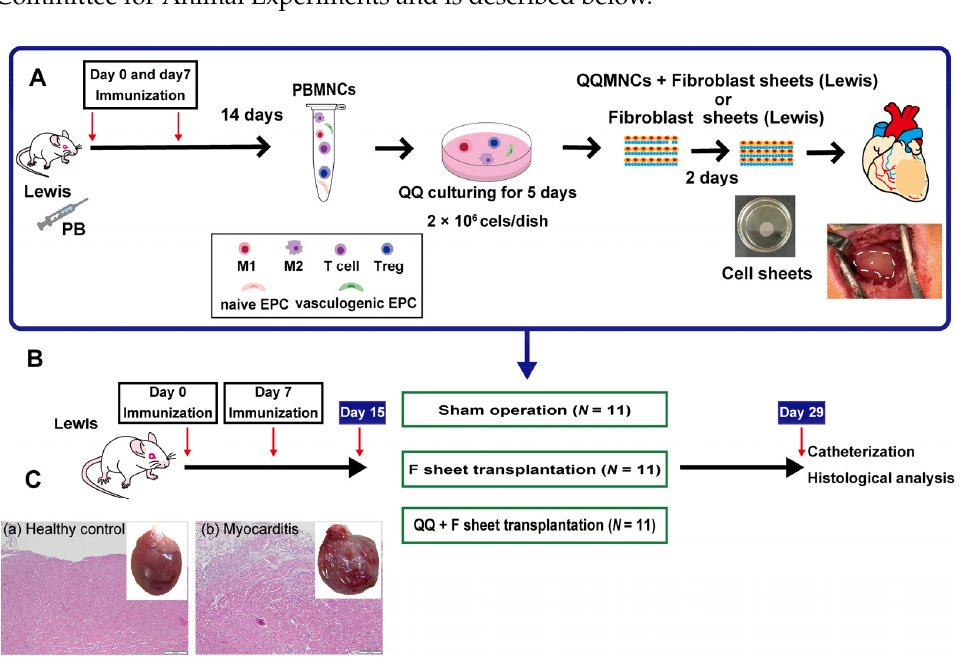
Figure 1. Experimental protocol. ( A ) Schematic flowchart of the in vitro protocol; Differentiation and purification of QQMNCs from rat peripheral blood and three harvested QQMNCs and fibroblast sheets (F-sheets). ( B ) Schematic flowchart of the in vivo protocol; Immunization and transplant of QQMNCs and F-sheets. ( C ) Representative images of the entire heart and heart tissue section stained with H&E at 15 days after immunization with procaine cardiac myosin (a) Healthy control ( × 4), (b) EAM ( × 4), Scale bar = 200 µ m. PB: peripheral blood, PBMNCs: peripheral blood mononuclear cells, QQMNCs: quality and quantity control culture of mononuclear cells, H&E: Hematoxylin and eosin stain, M1: M1 macrophage, M2: M2 macrophage, Treg: regulatory T cell, EPC: endothelial progenitor cell.